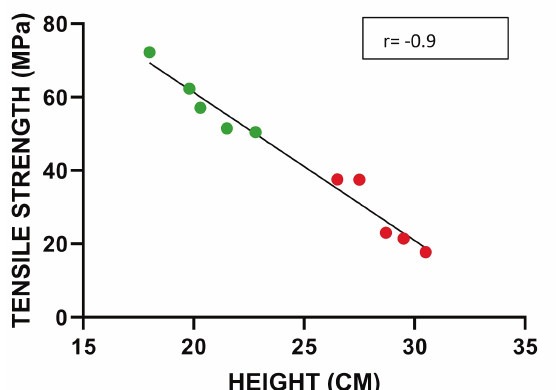
Fig. 6 ­ Scatter plots of tensile strength and total height measu­ red on treated plants (green) and control plants (red). The scatter plot indicates a significant negative correla­ tion between two variables with a correlation coefficient of r=­0.9,